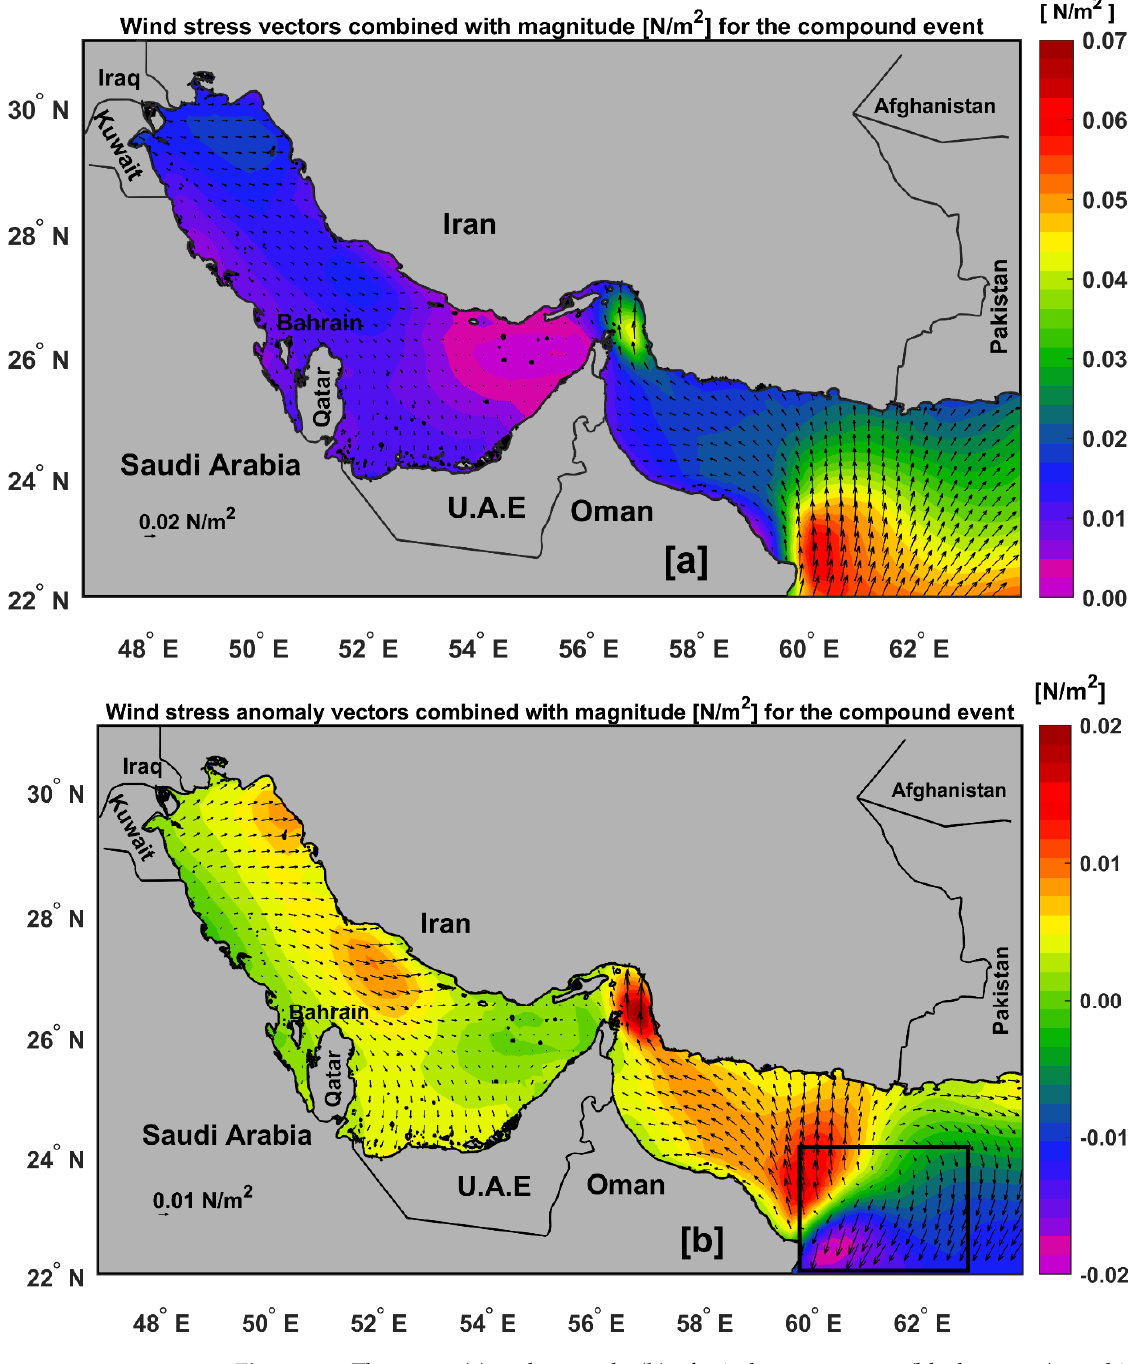
Figure 12. The mean ( a ) and anomaly ( b ) of wind stress vectors (black arrows) combined with magnitude (shading) in [N/m 2 ] during the longest compound MHW and LChl-a event (10 July to 21 August 2020). Note that the anomalies are calculated with respect to the period [1982–2020] from the hourly ERA5 data. The black rectangle in ( b ) defines the area that was affected by the compound event.